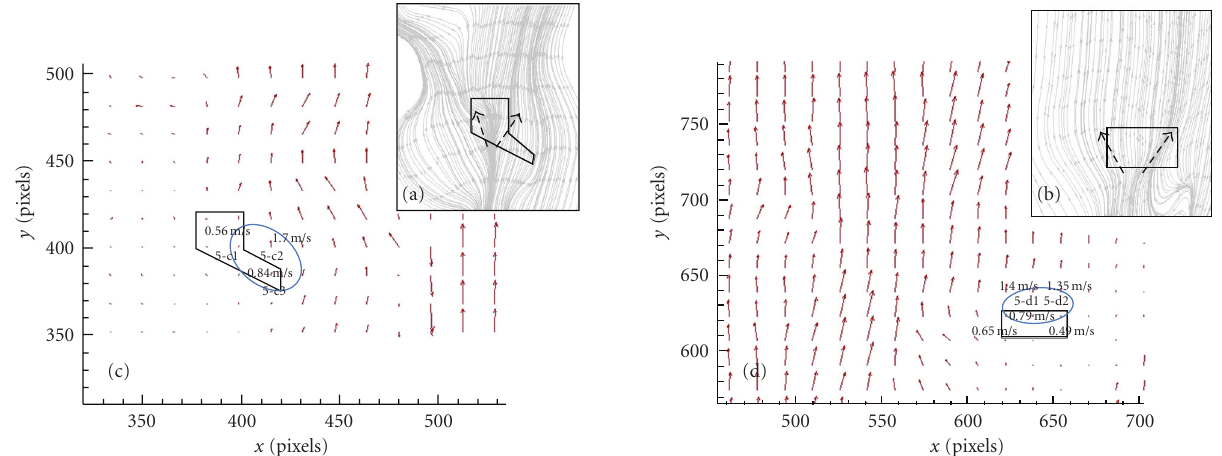
Figure 5: (a) and (b) Streamlines passing through the left (a) and right (b) flame edges of case 2. (c) Velocity variation at the left flame edge of case 2. The points’ velocities in the polygon are 0.42 m/s, 0.8 m/s, 0.56 m/s, 0.56 m/s, and 0.84 m/s (ordered by left to right and top down). The velocity of point 5-c2 is 1.7m/s. (d) Velocity variation at the right flame edge of case 2. The six points’ velocities in the rectangle are 0.65m/s, 0.79m/s, 0.49 m/s, 0.21 m/s, 0.2m/s, and 0.07 m/s (ordered by left to right, top down). The velocities of points 5-d1 and 5-d2 are 1.4m/s and 1.35 m/s.